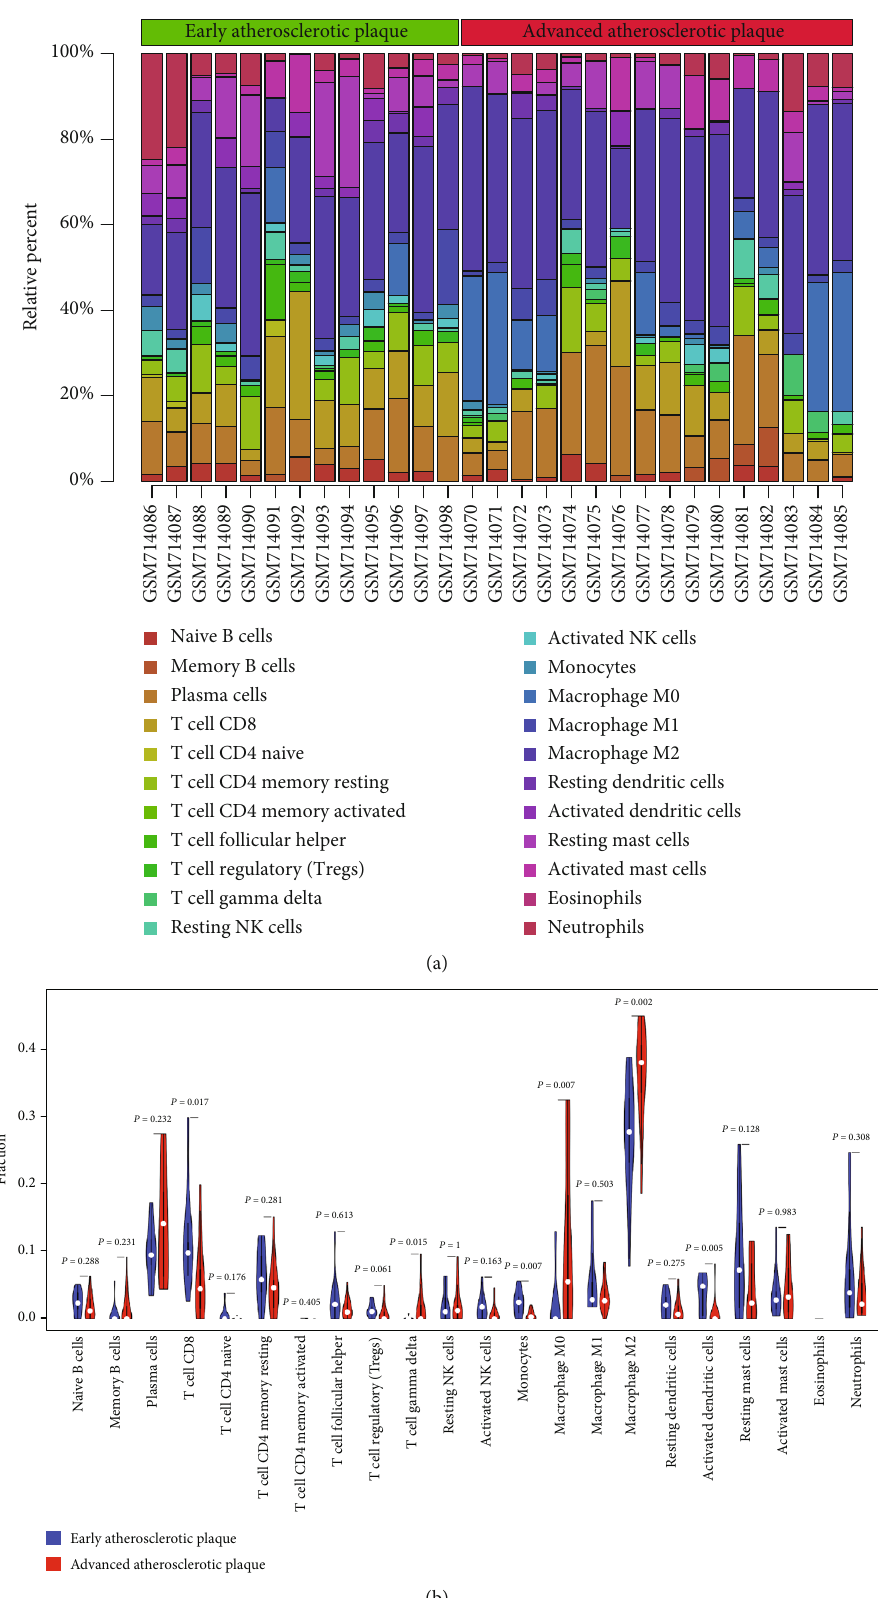
Figure 3: (a) Relative proportions of 22 types of in fi ltrated immune cells in EA and AA groups. (b) Signi fi cant changes in in fi ltrated immune cells in AA compared to EA group (Wilcoxon test p < 0 : 05